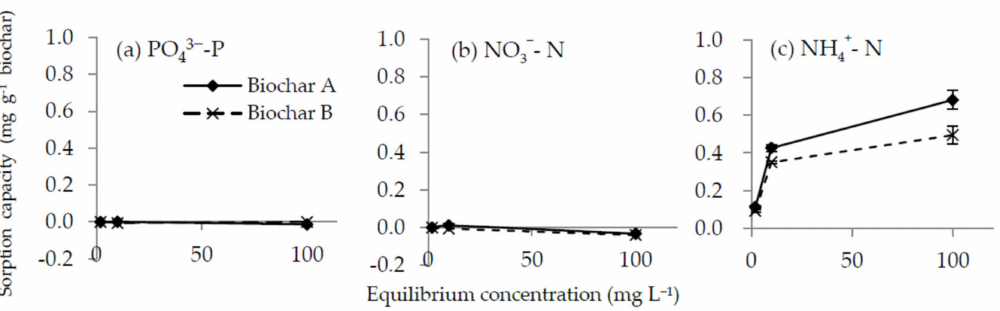
Figure 2. Sorption isotherm of two di ff erent types of biochar to PO 43 − ( a ), NO 3 − ( b ) and NH 4 + ( c ). Error bars indicate the standard deviation of four replicates (n =